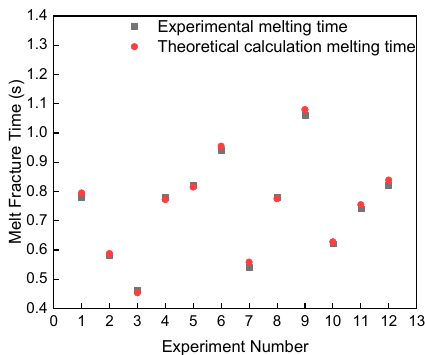
Figure 12. Relationship between metal wire melting experiment and theoretical calculation.